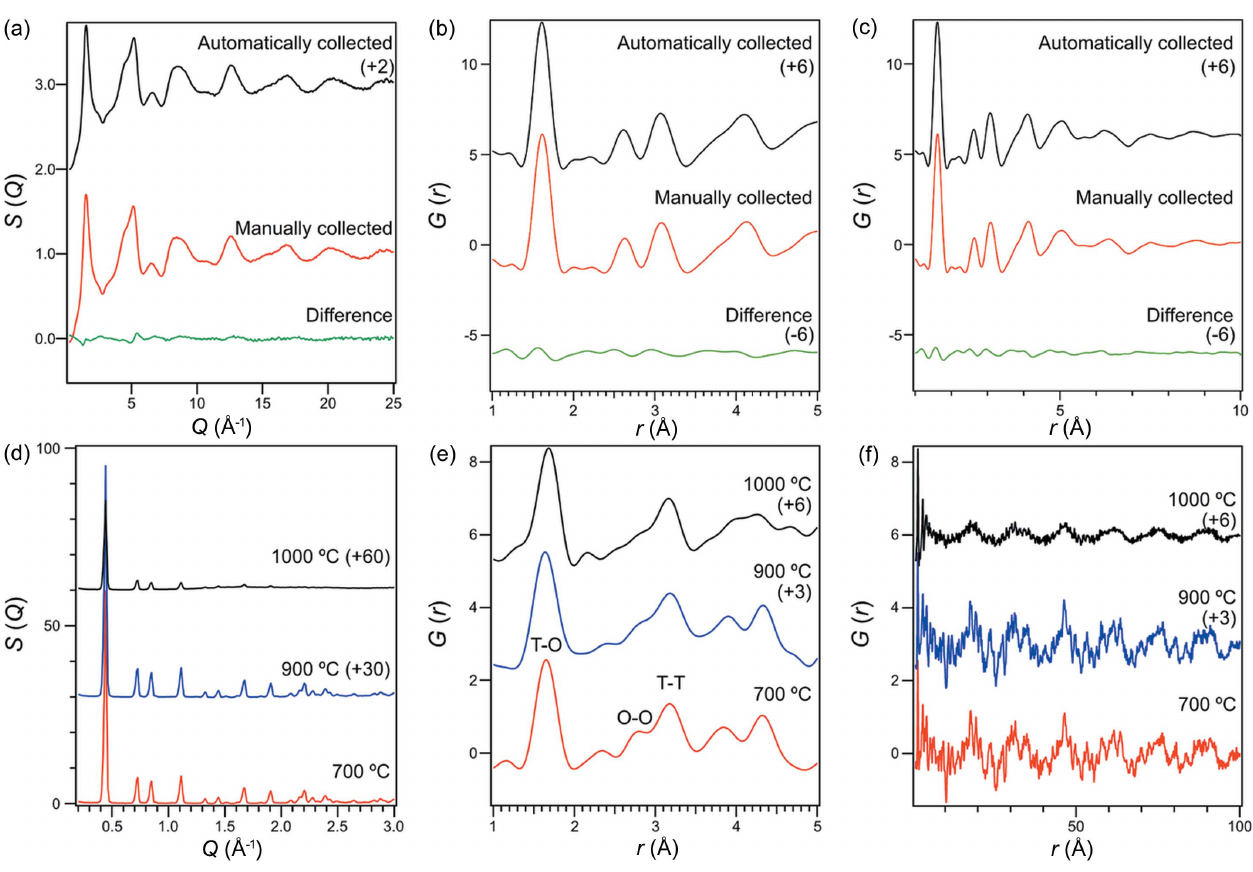
Figure 3 Data obtained from automated X-ray total scattering measurements. ( a ) S ( Q ) of silicate glass. ( b ) Comparison of G ( r ) values of silicate glass. ( c ) Comparison of G ( r ) values of silicate glass in a wide range. ( d ) S ( Q ) profiles of FAU zeolites at different temperatures. ( e ) G ( r ) values of FAU zeolites at different temperatures. ( f ) G ( r ) values of FAU zeolites at different temperatures with a wide